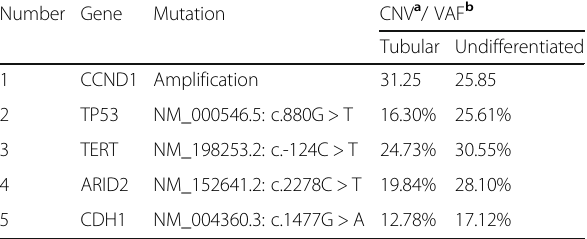
Table 1 Shared gene alterations of the undifferentiated and tubular components in the undifferentiated gallbladder